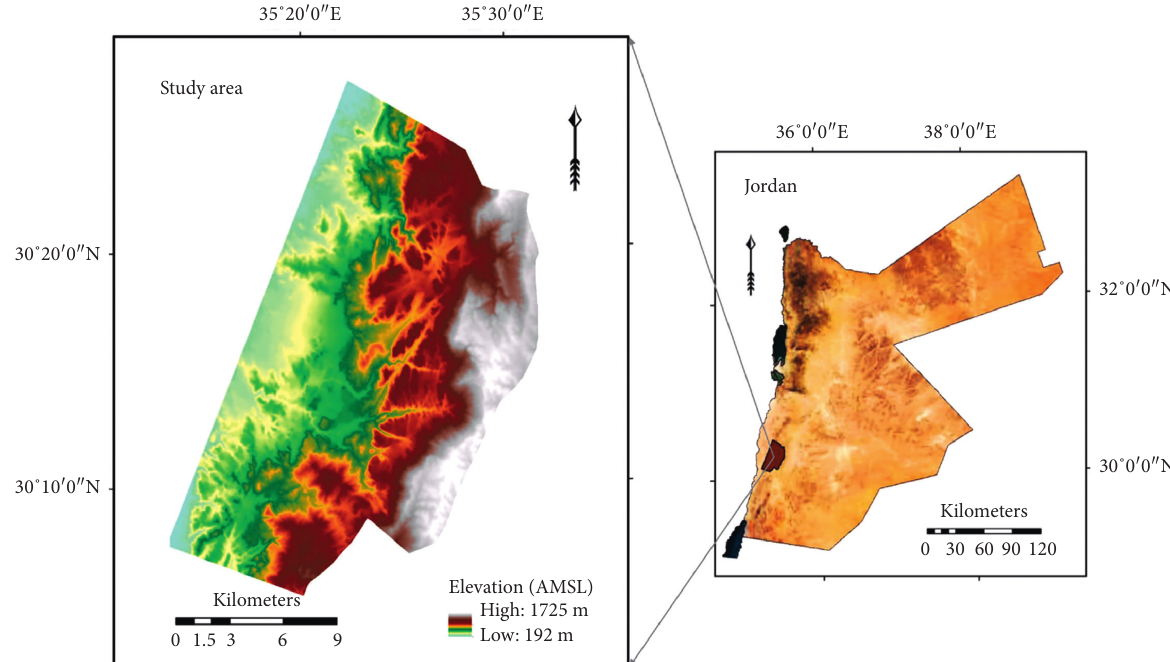
Figure 3: Location of Wadi Musa (geographical coordinates; WGS